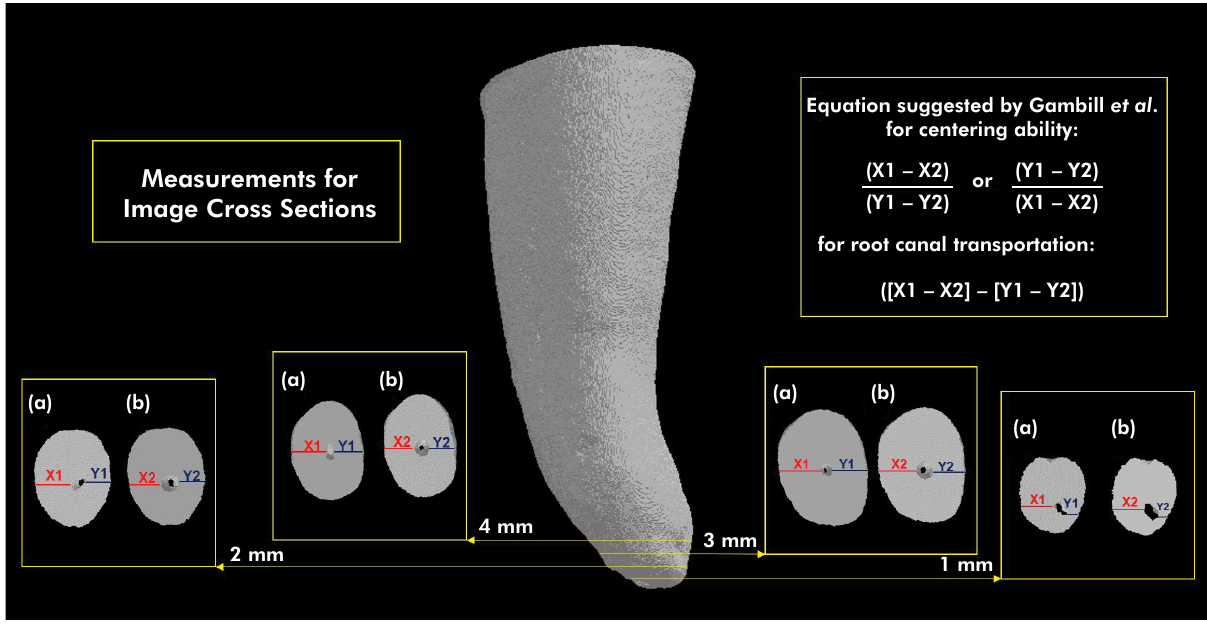
Figure 1. Representative images of the matching of axial reconstructions with the method used to detect root canal transportation in the last four millimeters of the apical portion: a) Axial sections indicating the thickness of the preoperative root canal dentin (X1 and Y1) and b) thickness of the dentin where root canal transportation (X2 and Y2) occurred in the postoperative